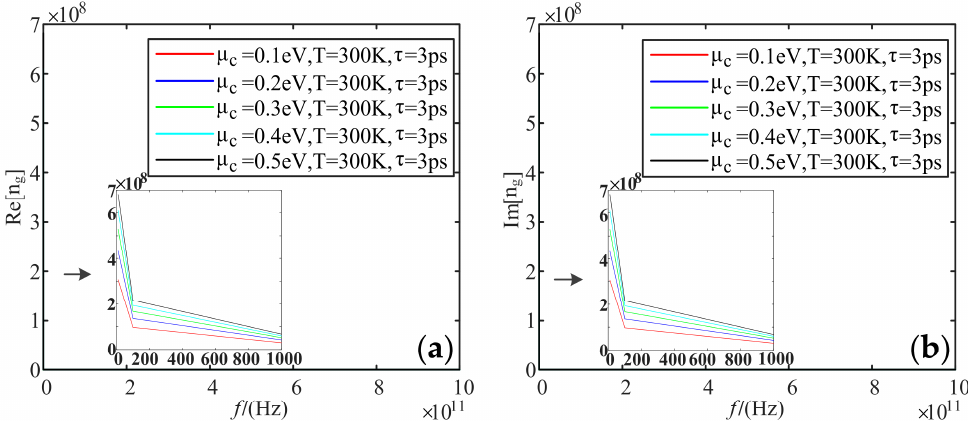
Figure 10. Variation curve of the refractive index of graphene with frequency at different electro- chemical potentials: ( a ) real part; ( b ) imaginary part.